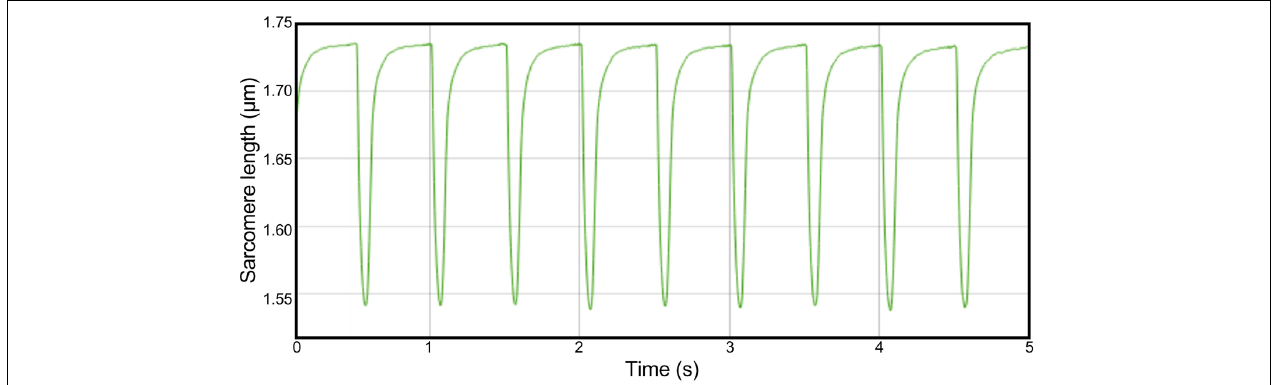
FIGURE 1 | Example trace of a full-length recording in a single cell. Cells were paced with a frequency of 2 Hz. Sarcomere length was measured for 5 s, in which 8 or 9 contractions could be